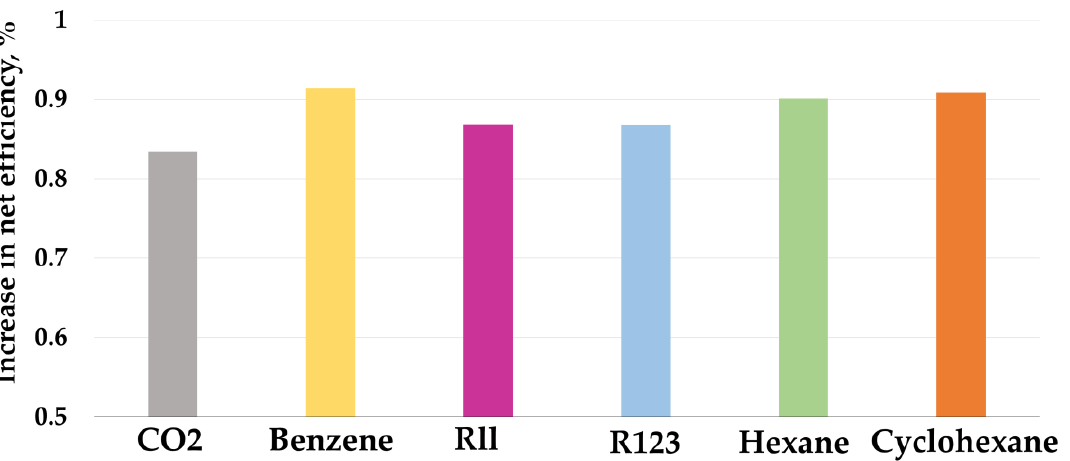
Figure 7. Increase in net efficiency during the Allam cycle LGH utilization with gasification.